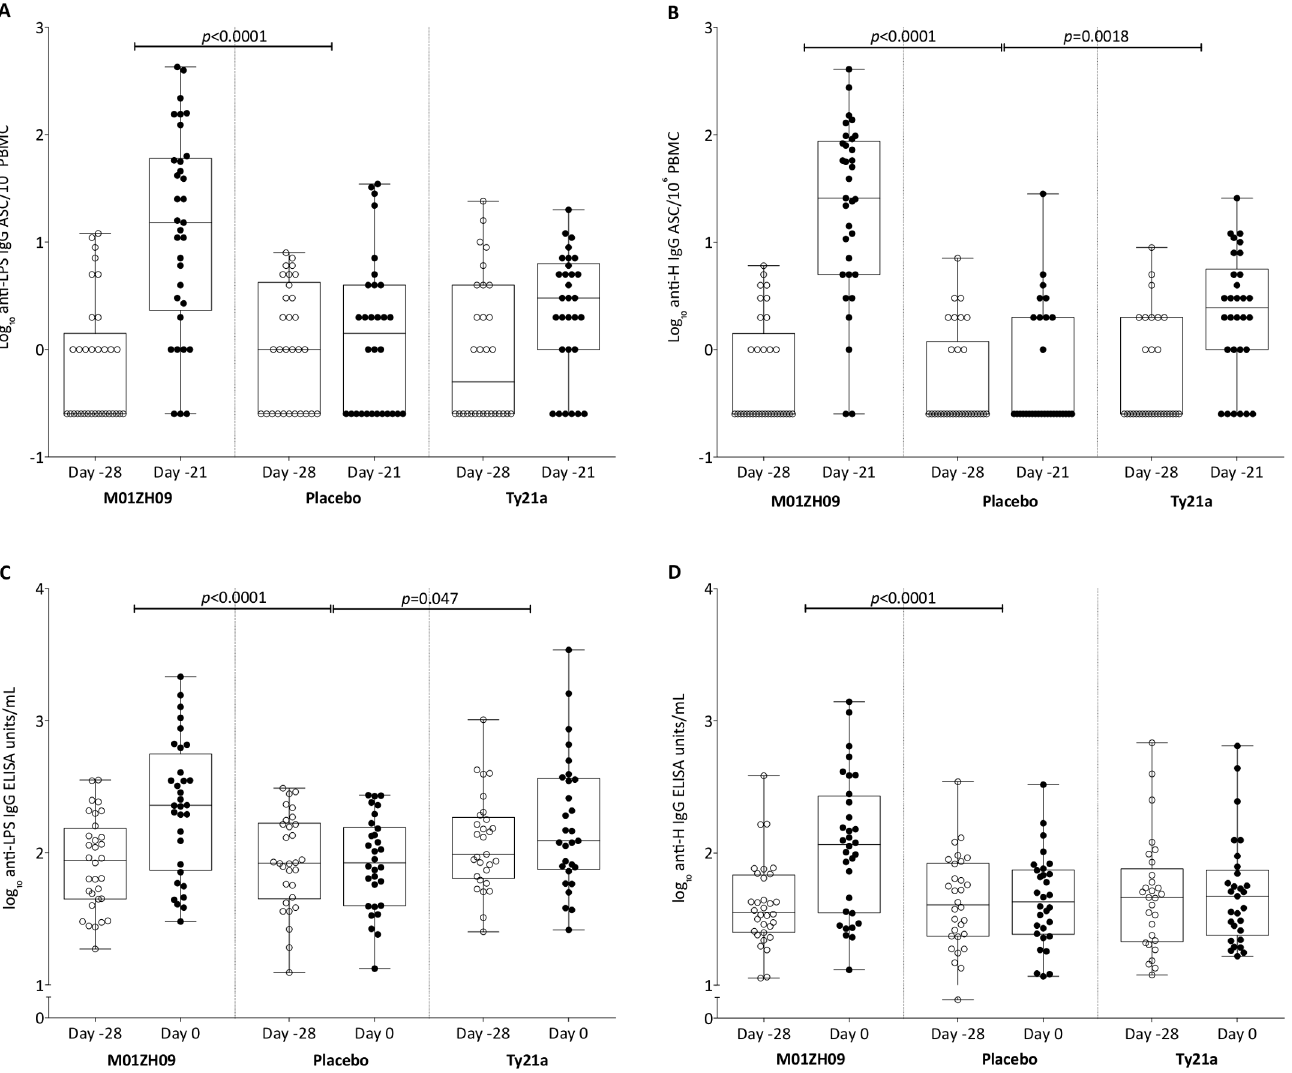
Fig 10. Immunoglobulin G ASC and antibody responses to S . Typhi LPS and flagellin before (Day -28) and after vaccination (either Day -21 or Day 0 for ASC and ELISA assays, respectively). (A) LPS and (B) flagellin specific IgG antibody secreting cell responses, respectively, measured pre-vaccination (Day -28) and 7 days later (Day -21). (C) Anti-LPS and (D) anti-flagellin antibody titres, respectively, measured pre-vaccination (Day -28) and 28 days later (Day 0, i.e. prior to S . Typhi challenge). Data are grouped according to vaccine